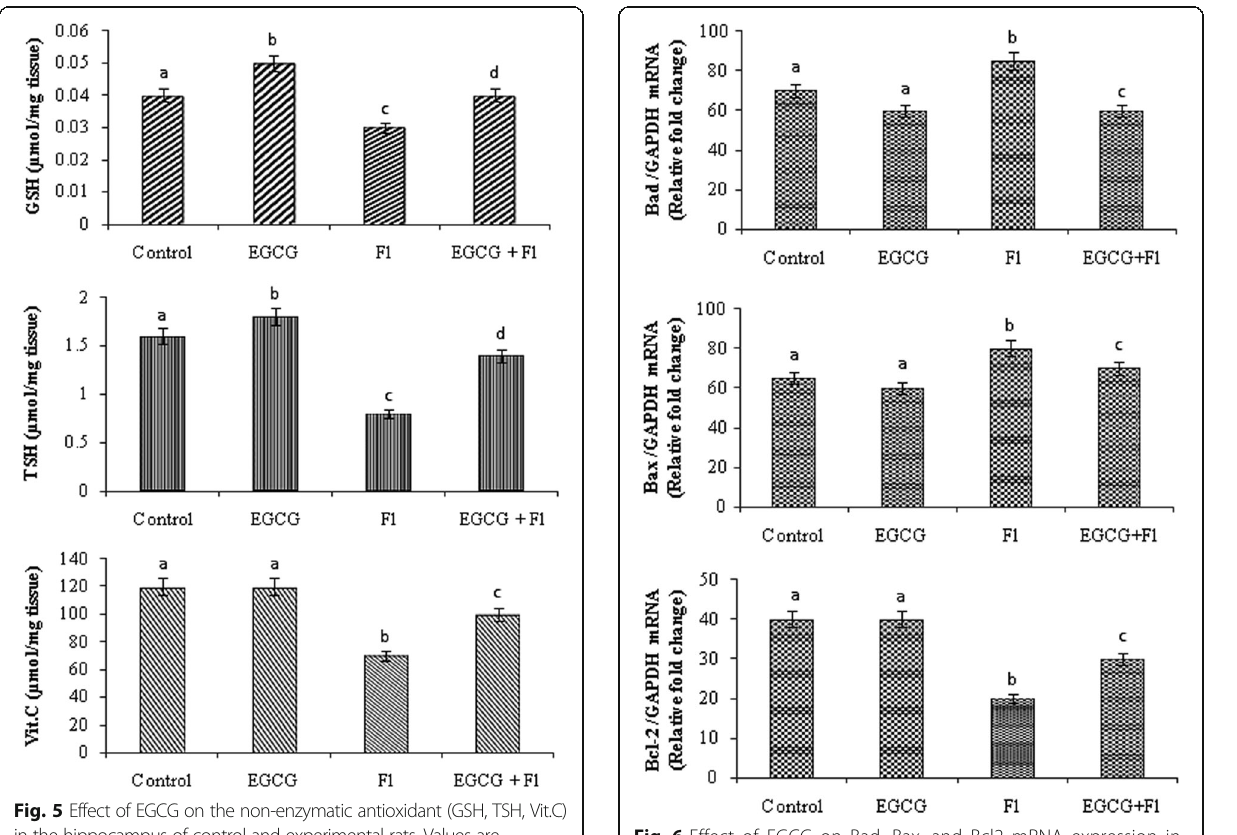
Fig. 6 Effect of EGCG on Bad, Bax, and Bcl2 mRNA expression in the hippocampus of control and experimental rats. Values are mean ± SD for 6 rats in each group. a, b, c Values not sharing a common superscript letter (a, b, and c) differ significantly at p < 0.05